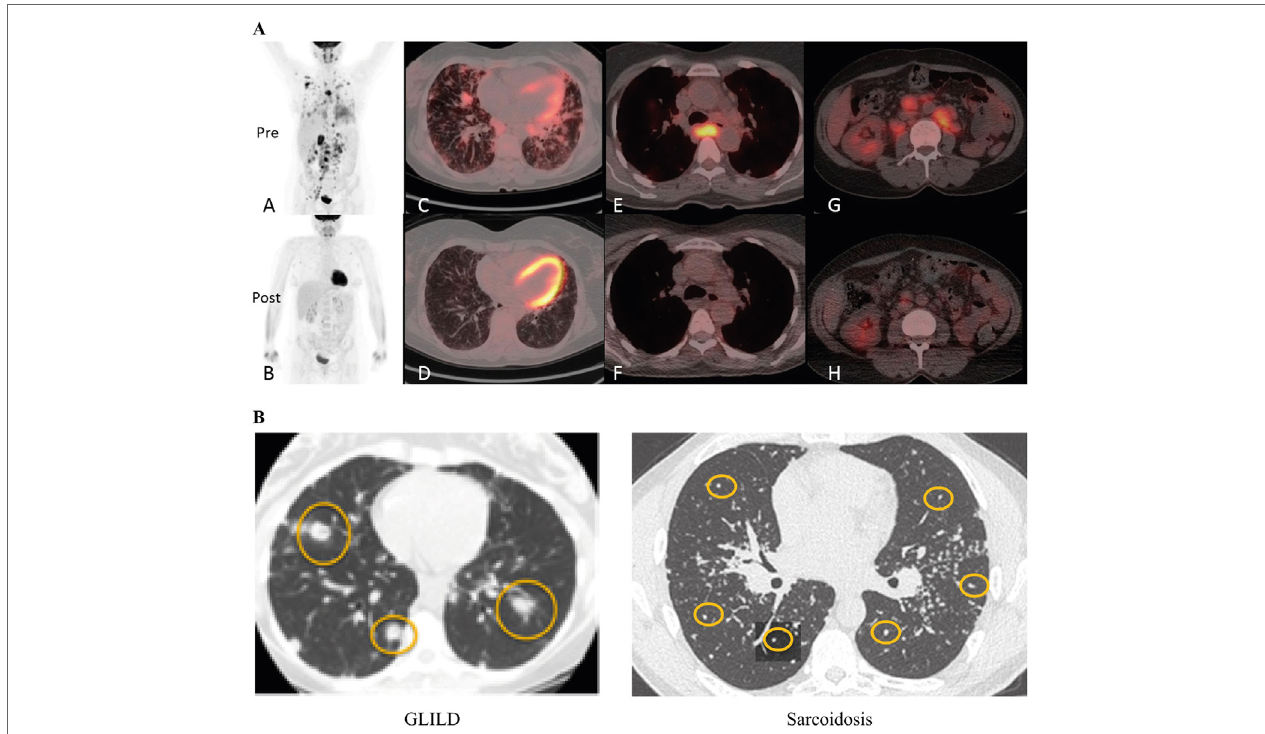
FigURe 7 | Diagnosis of granulomatous-lymphocytic interstitial lung disease (GLILD). (A) PET-CT before and 3 months after rituximab and mycophenolate treatment. Whole body images were acquired at 90 min following 285 MBq 2-[(18)F]-fluoro-2-deoxy-d-glucose (tracer). Maximum intensity projection whole body images before treatment show widespread abnormal uptake of tracer in the lung parenchyma and lymph nodes above and below the diaphragm (A); images following treatment show near resolution of all the areas of abnormal tracer uptake (B). (C,D) Axial fused positron emission tomography–computed tomography (PET–CT) images at the mid-thoracic level. The level of tracer uptake is represented by the intensity of color superimposed upon the CT image. There is a combination of interstitial septal thickening and ill-defined tracer-avid peri-bronchovascular nodules before treatment (C); post-treatment image shows improvement of the nodularity with near resolution of tracer uptake (D). Images at the level of the carina show an enlarged lymph node exhibiting intense abnormal tracer uptake prior to treatment (E), and a normalized lymph node with no abnormal tracer uptake following treatment (F). Pre-treatment images through the abdomen at the level of the right renal hilum demonstrate numerous enlarged tracer-avid retroperitoneal lymph nodes (G) which reduce in size and tracer uptake following treatment (H). Reproduced with kind permission from 2016 British Society for Immunology, Clinical and Experimental Immunology, 187: 138–145 (100). (B) Radiographic features of GLILD versus sarcoidosis. GLILD is characterized by macronodular (yellow circles) disease that is located predominantly in the lower lung zones. In contrast, micronodular (yellow circles) disease located in the upper lung zones and frequently accompanied by marked hilar adenopathy (stars) is characteristic of sarcoidosis. Reproduced from Ref. (101) with kind permission from European Respiratory